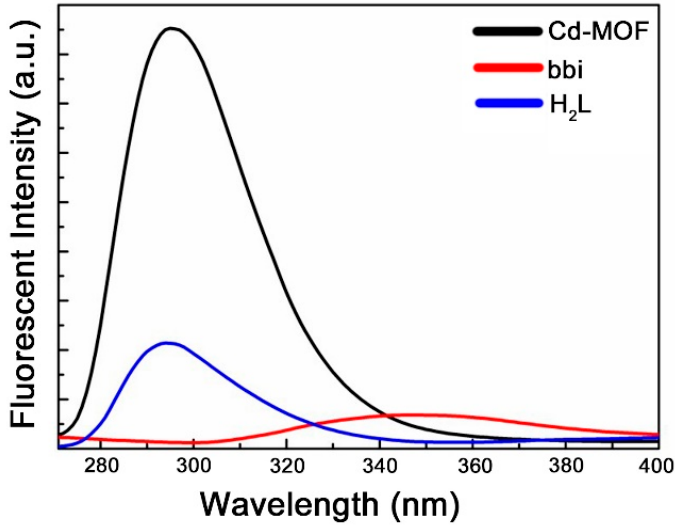
Figure8. ThefluorescencespectraofsolidsamplesofCd-MOF,bbi, andH 2 Lorganicligand. Reproduced Figure 8. The fluorescence spectra of solid samples of Cd-MOF, bbi, and H 2 L organic ligand. and adapted from Ref. [54]; Copyright (2019), RSC Reproduced and adapted from Ref. [54]; Copyright (2019), RSC Analyst.